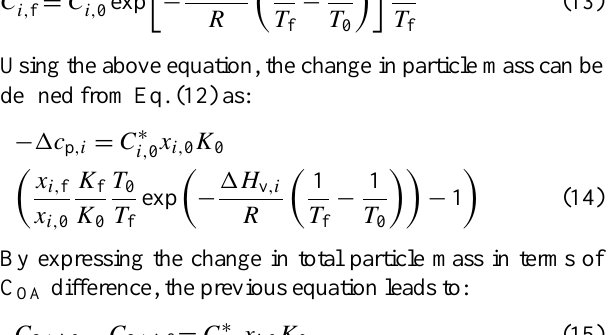
Fig. 9. Output thermograms for heating section (HS), cooling sec- tion (CS) and denuder section (DS) in a system with 92nm α -pinene SOA particles at 500µgm − 3 aerosol loading, in comparison with experiments by Cappa and Wilson (2011). The calculations were conducted for different evaporation coefficients ( γ 0 evap ) and a re- condensation coefficient ( γ 0 ) equal to unity, under the assump- cond tion that the particle phase does not affect the re-condensation pro- cess. The results show a best fit between observations and model for an evaporation coefficient between 0.01–0.001, with an optimum for γ 0 =0.01. Data represent the upper estimate for re-condensation unless otherwise